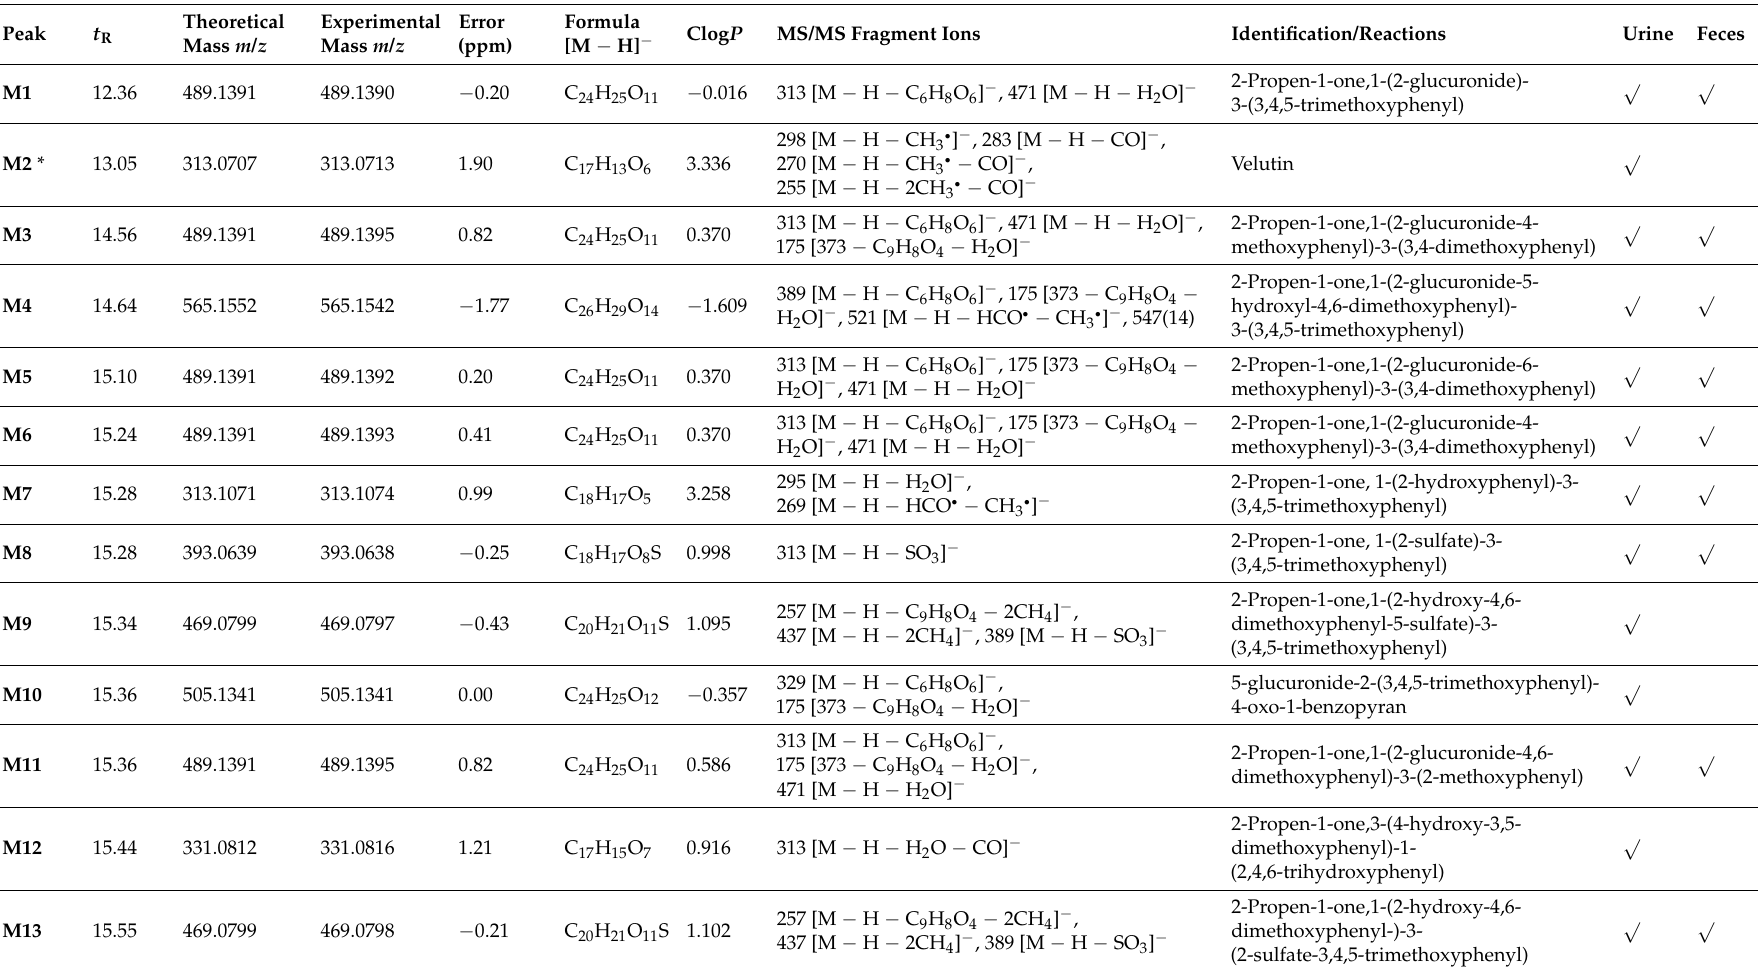
Table 1. Characterization of metabolites in the rat urine and feces after oral administration of